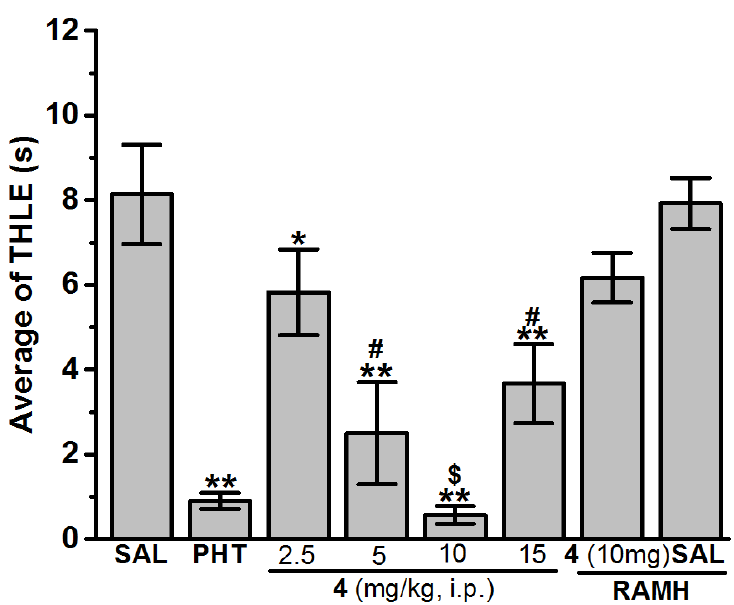
Figure 1. Dose-dependent protective effect of histamine H3 receptor (H3R) antagonist 4 and effect of ( R )- α -methylhistamine (RAMH) pretreatment on the H3R antagonist 4 provided protection against maximal electroshock (MES)-induced convulsions. The figure shows the protection provided by standard antiepileptic drug (AED) phenytoin (PHT, 10 mg/kg, i.p.) and test compound 4 (2.5, 5, 10, and 15 mg/kg, i.p.) on the duration of tonic hind limb extension (THLE) induced in the MES model in rats. Each value represents mean ± standard error of mean (SEM) ( n = 6 – 7). * p < 0.05 vs. sal (saline)- treated group. ** p < 0.001 vs. (saline)-treated group. # p < 0.05 vs. (2.5 mg)-treated group. $ p < 0.05 vs. (5 mg or 15 mg)-treated groups. Table 2. Screening of in vivo anticonvulsant effects for H3R antagonists 1 – 16 . Ligand Structure − − −